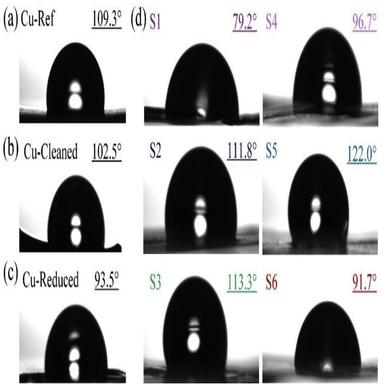
Contact angle measurements for (aec) Cu-foils at the pretreatment and before being exposed to vapors and (c) Cu-foils after the CVD experiment. (A colour version of this figure can be viewed online.)